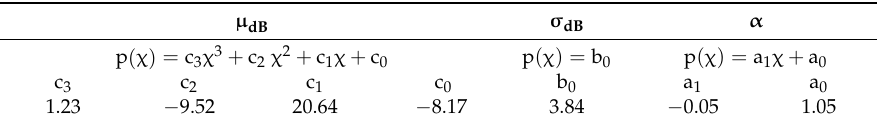
Table 2. Parameters for SSF environment.